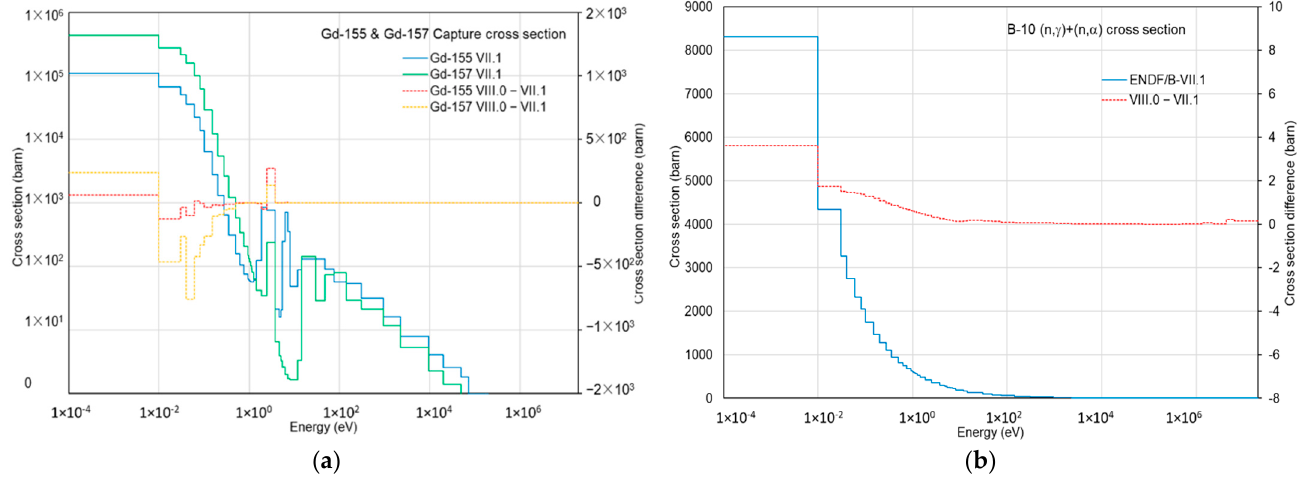
Figure 10. Comparison of the flux-weighted capture cross sections between ENDF/B-VII.1 and -VIII.0 in the 51-group structure: ( a ) 155 Gd and 157 Gd; ( b ) 10 B.